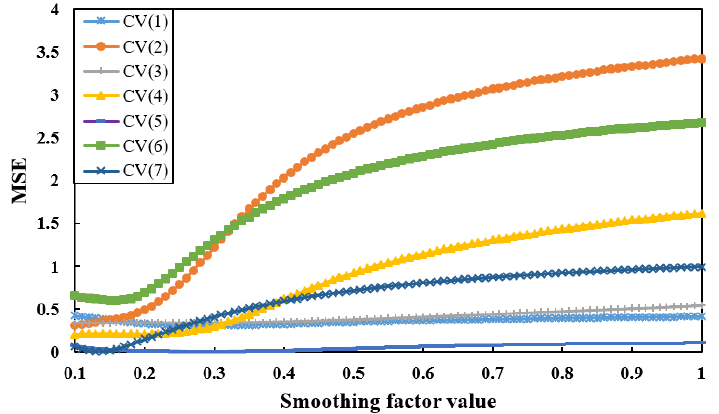
Figure 5. Effect of smoothing factor on GRNN performance under different cross-validations (CV(1)–CV(7)).